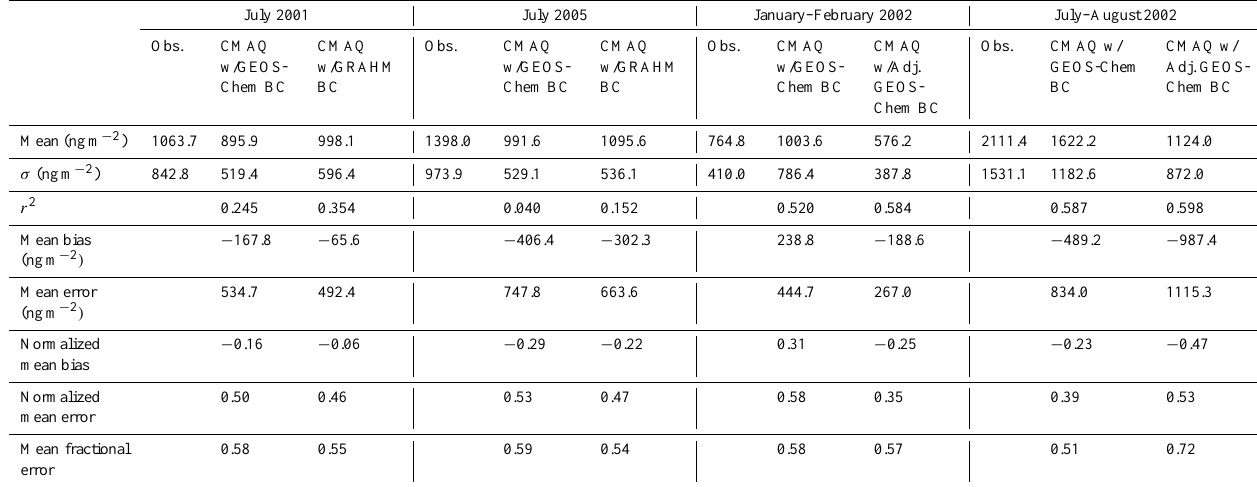
Table 3. Observed and Simulated Mean and Standard Deviation for Monthly (or Bi-Monthly) Hg Wet Deposition at All Monitors and Model Correlations to All Observations of Monthly (or Bi-Monthly) Hg Wet